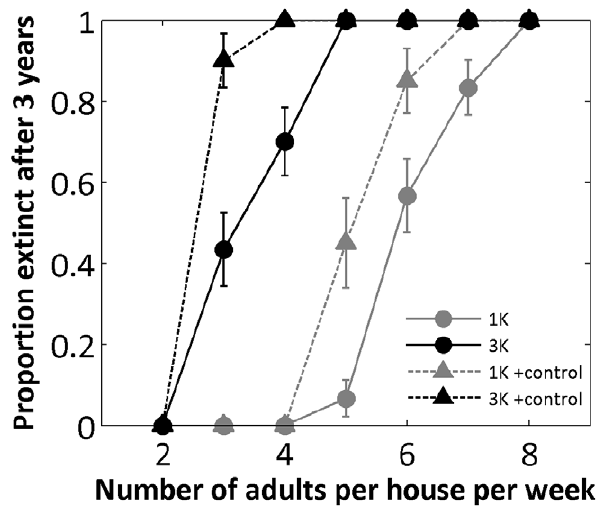
Figure 1. Adult male releases in each house (homogeneous strategy). Proportion of simulations that reach extinction after 3 simulated years when males are released weekly. For each scenario 30 replicated simulations were run. Solid lines and circles: simulations without pre-release control; dashed lines and triangles: simulations with 2-week pre-release insecticidal control. Gray lines: 1 lethal element (1 K); black lines: 3 lethal elements (3 K). Error bars show estimated proportion ( p ) + / 2 standard error (calculated using SE ~ with n =30